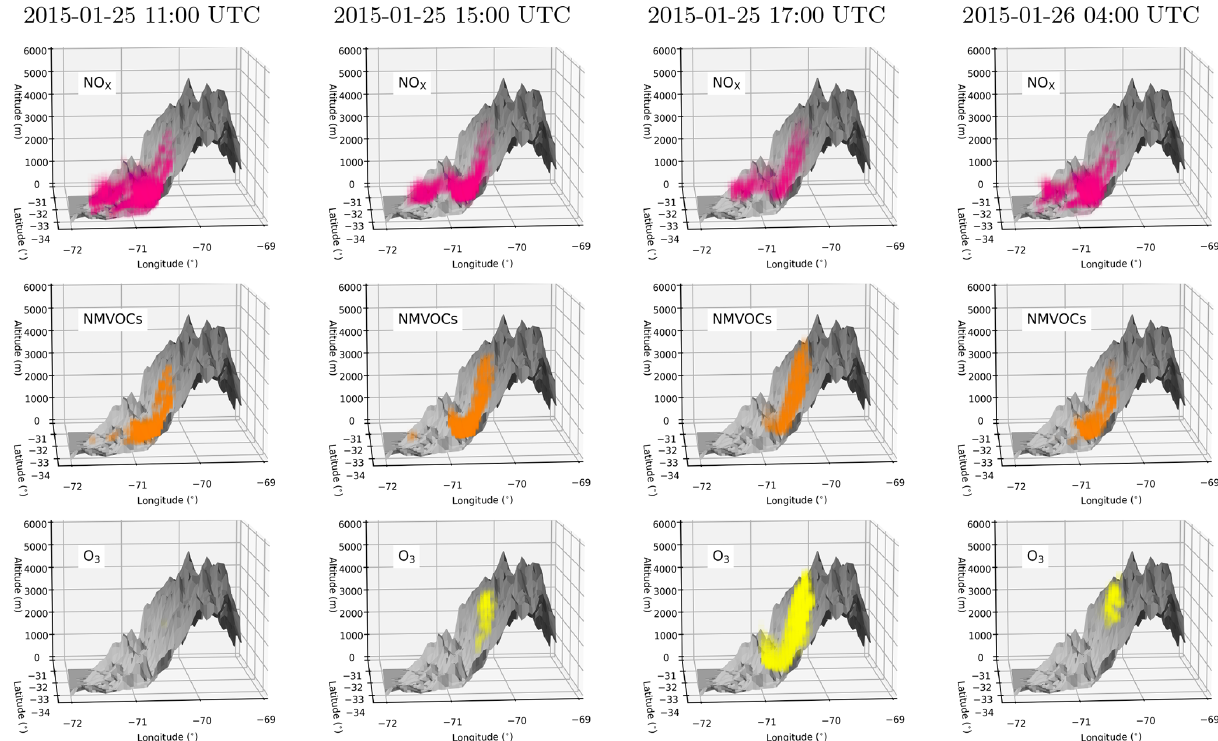
Figure 10. Cycle of NO x (top), NMVOC (middle) and O 3 (bottom) venting in the vicinity of Santiago for a typical day in January 2015. Hourly mixing ratios in excess of 2, 20, and 60ppb are shown, respectively. Each panel shows a 3-D view from a longitudinal perspective. Gray surfaces represent the terrain topography. Times for Santiago are universal coordinated time (UTC − 3) for this